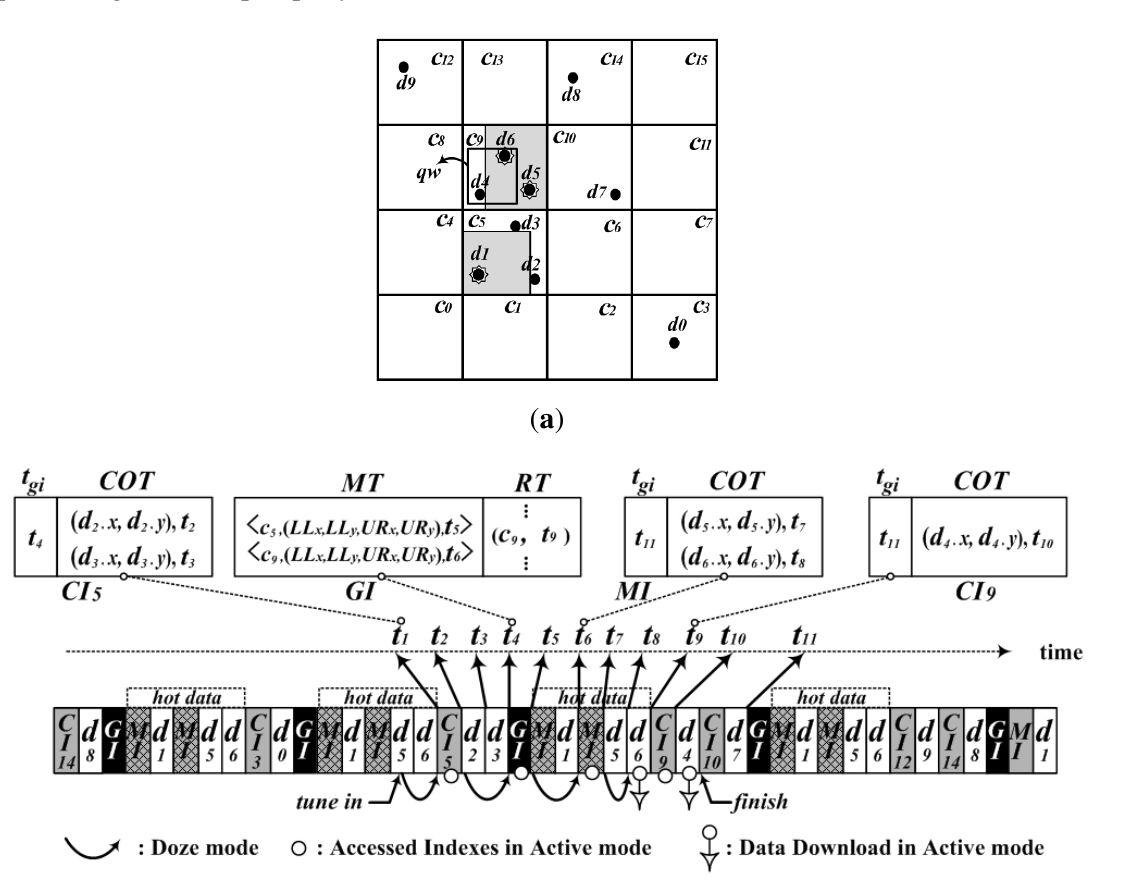
Figure 5. An example for query processing. ( a ) An Example Query; ( b ) The procedure for processing the example